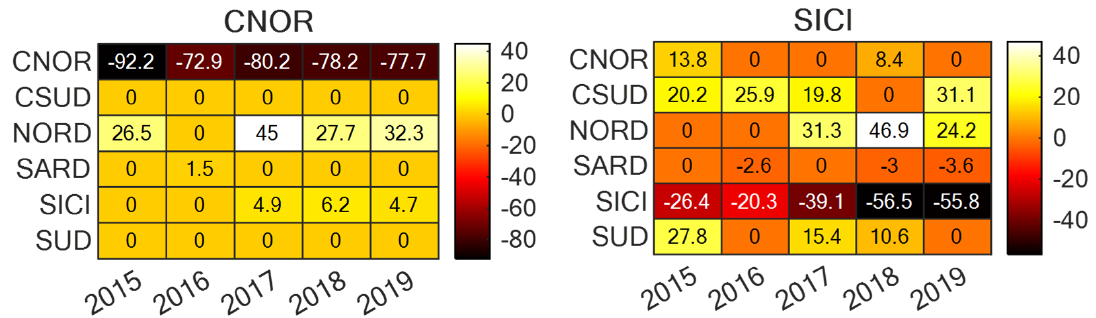
Figure 7. Heatmap chart of the impact of 100 MWh increases in solar generation in CNOR and SICI on the net input flow (MW); results of Equations (1) and (2).